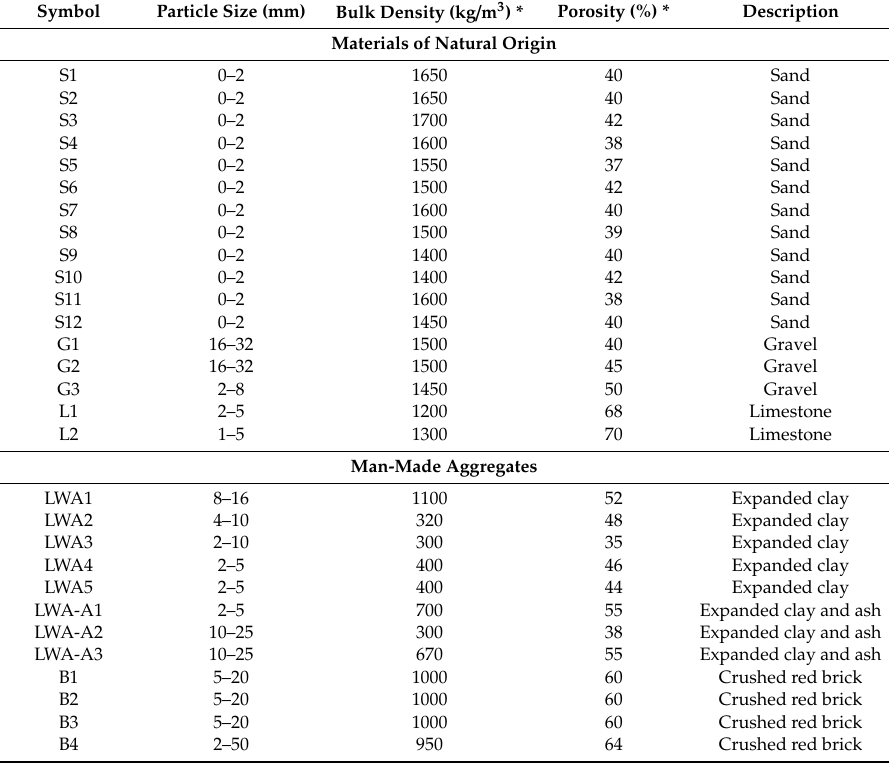
Table 2. Characteristic of green roof substrates compounds analyzed in the